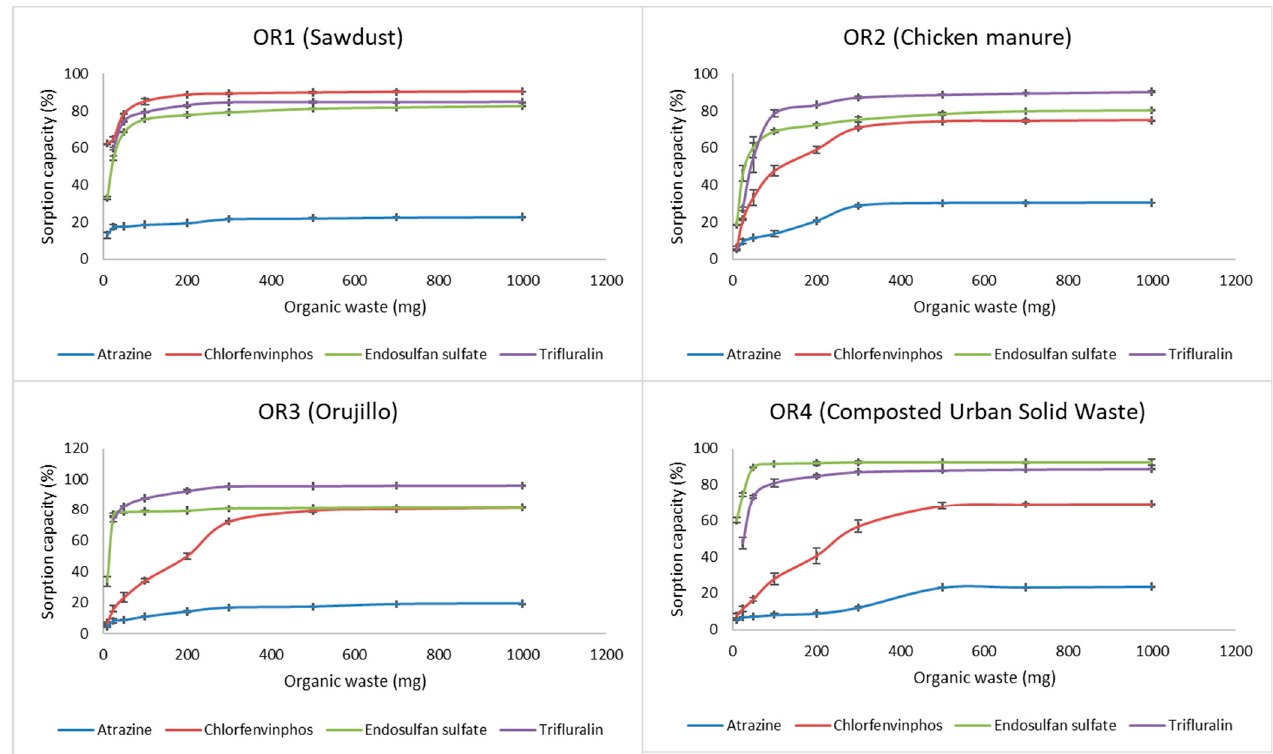
Figure 1. Sorption capacity of the sorbents (OR1—sawdust, OR2—chicken manure, OR3—olive oil solid waste “orujillo” and OR4—composted urban solid waste) for pesticides.